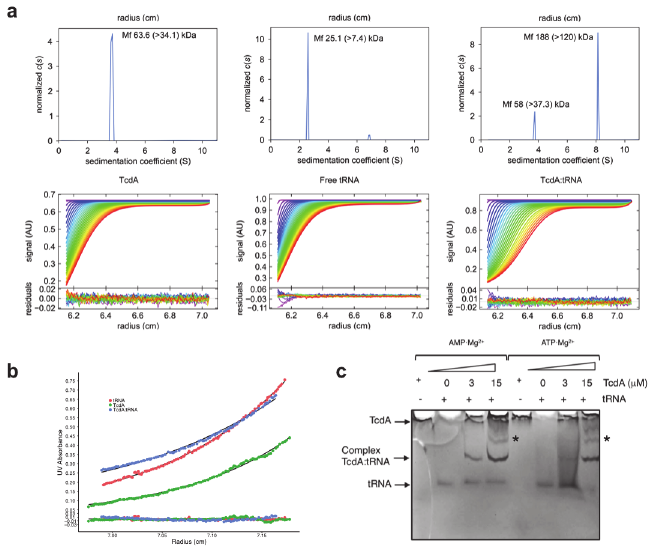
Fig 7. TcdA binding to tRNA. a SV-AUC experiments demonstrate that TcdA contains a tRNA Lys binding domain. Sedimentation coefficient (S) continuous distributions, c(S), plotted for TcdA, tRNA Lys , and the TcdA- tRNA Lys complex. Representative sedimentation scans and residuals after fitting are shown. For each c(S) distribution, the estimated molecular mass and the smallest mass compatible with the experimental results are indicated. b Absorbance at 280 nm plotted against the AUC column length for SE-AUC experiments for TcdA, tRNA Lys , and TcdA-tRNA Lys . Residuals after fitting are also shown. c Electrophoretic mobility shift assay (EMSA) provides evidence for the physical binding of TcdA to tRNA Lys . Samples were run over a 8% TBE-PAGE gel at 4°C for 1 h to fully resolve tRNA Lys from TcdA-tRNA Lys bands. TcdA does not enter the gel when tRNA Lys is not added, most likely due to its intrinsically basic isoelectric point, pI (theoretical pI = 8.8). tRNA Lys alone migrates as the fastest migrating band. When 5 M tRNA Lys is added to 3 μ M or 15 μ M TcdA, protein-tRNA Lys complexes develop that migrate behind free tRNA Lys . An arrow indicates the position of the retardation band containing the most abundant TcdA-tRNA Lys complex (2:2 stoichiometry), and an asterisk marks the position of a slower migrating TcdA-tRNA Lys complex (most likely, 2:1